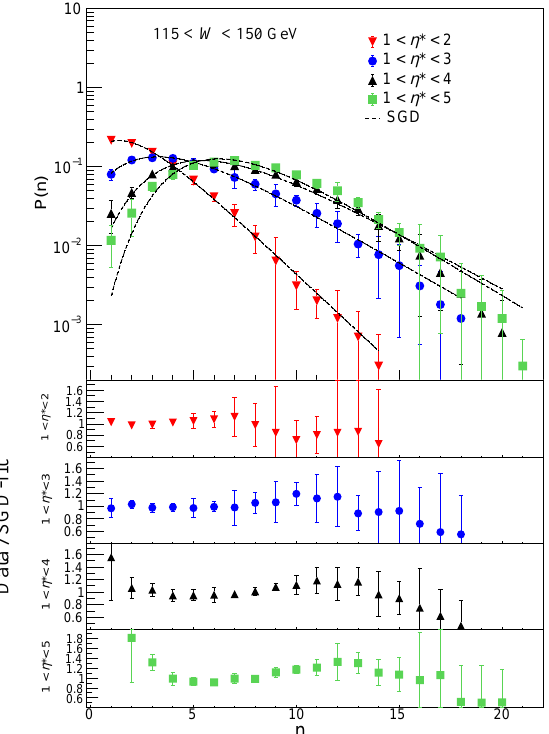
Figure 3. Multiplicity distributions for SGD fits to the data [33] in different η ∗ ranges for 115 < W < 150 GeV. The lower panel shows the data/SGD-fit ratio plots for different η ∗